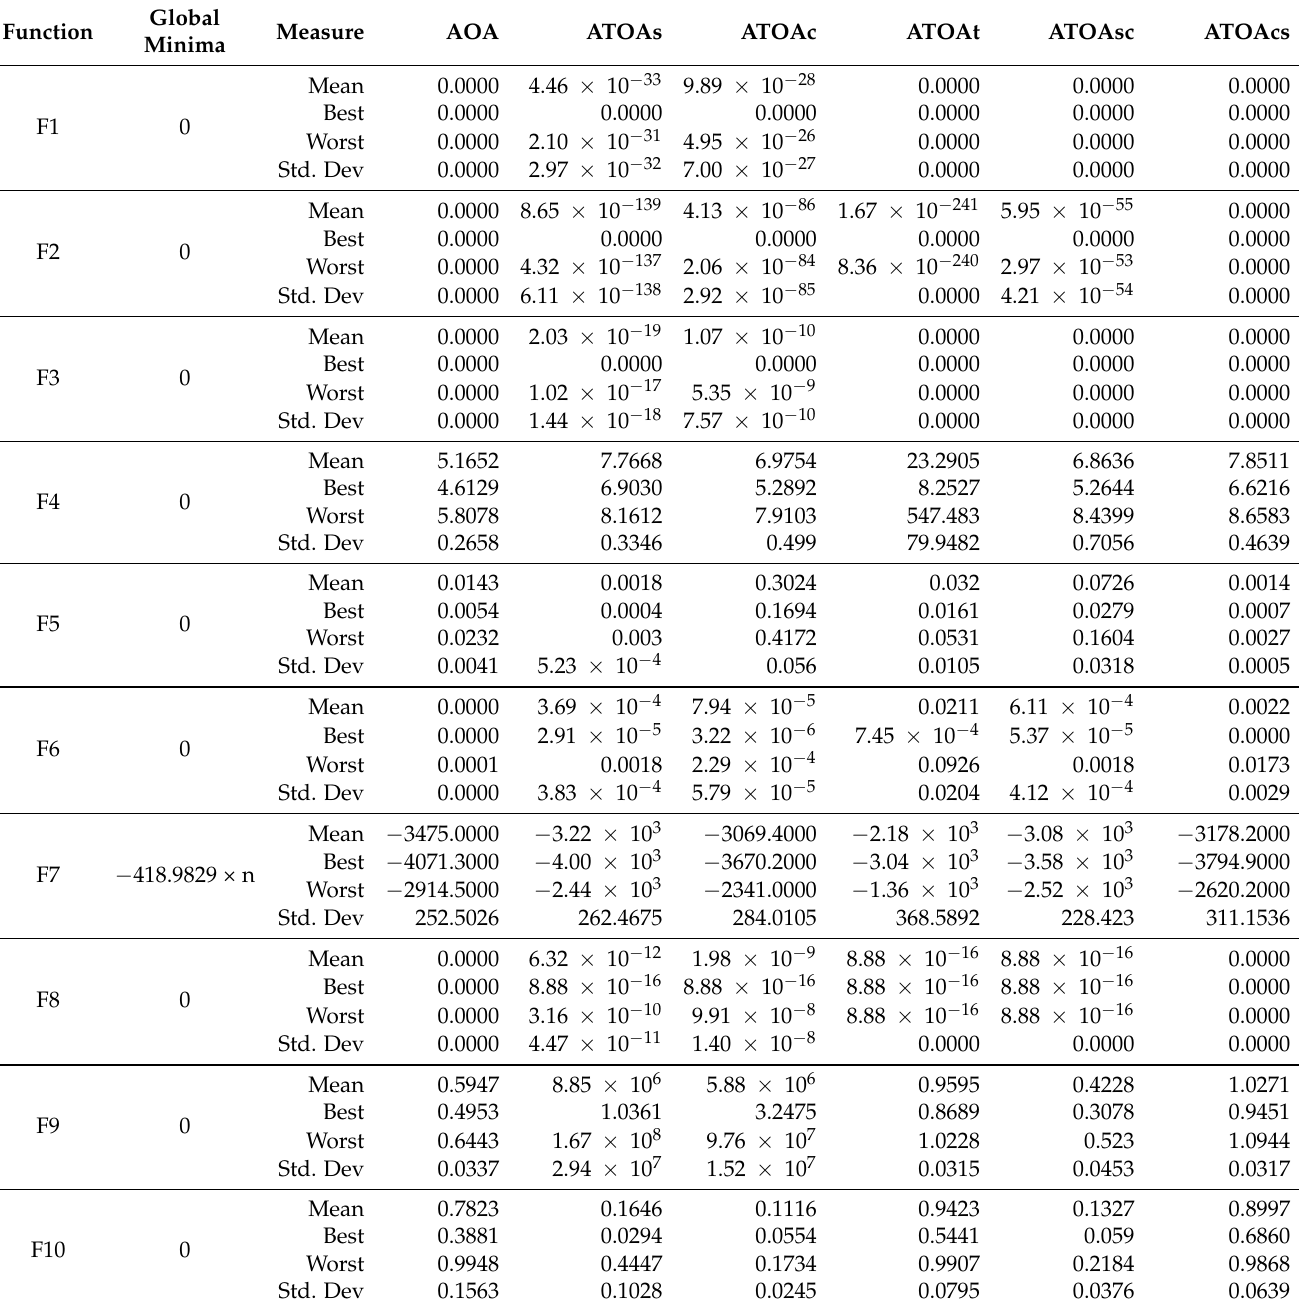
Table 3. Comparisons of the statistical results obtained from the different variants of the ATOA algorithms on various benchmark